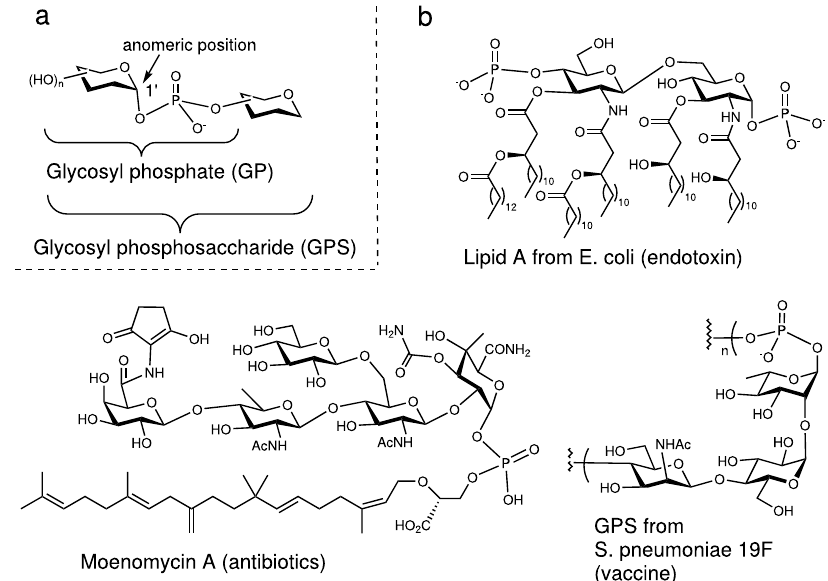
Fig. 1 Introduction of glycosyl phosphate and glycosyl phosphosaccharide. a Nomenclatures for glycosyl phosphate and phosphosaccharide. b Representative bioactive